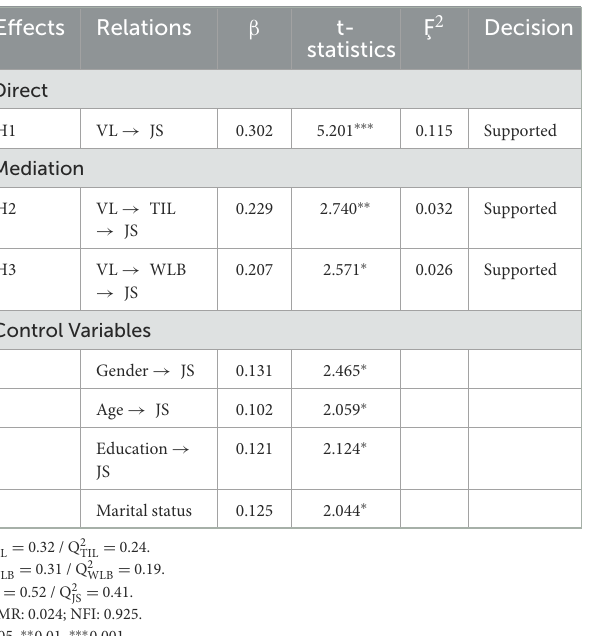
TABLE 5 Structural model and hypothesis